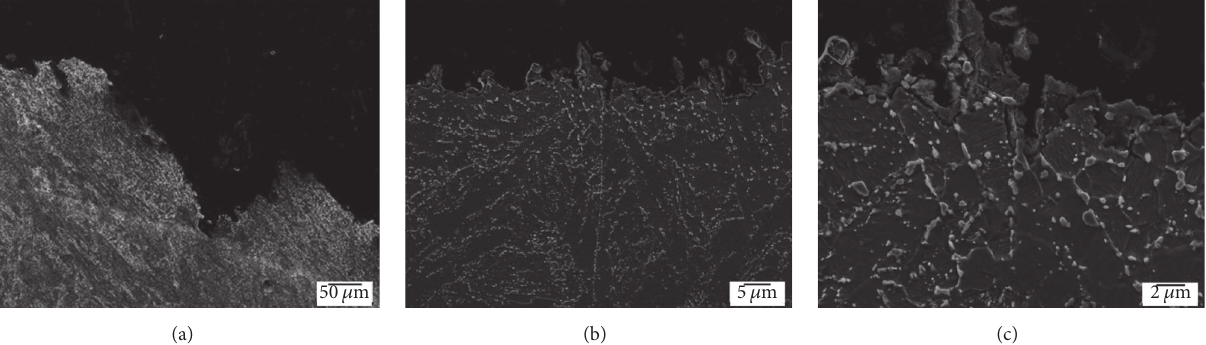
Figure 14: Fracture path (a, b, c) and creep cavity (c) analyses of CB2 weldment ruptured by “type III failure” after the creep test at 625 ∘ C, 80 MPa.